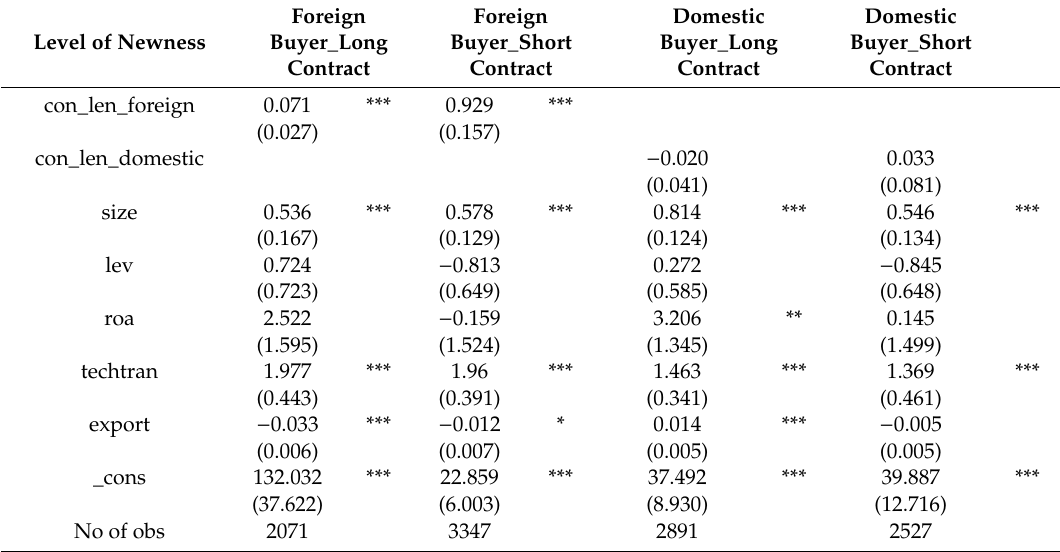
Table 7. Contract length and the aimed level of